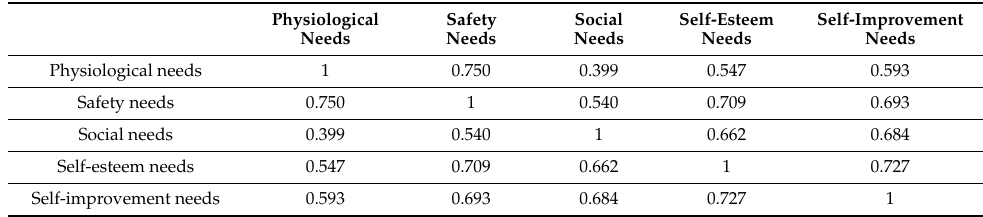
Table 3. Pearson Correlation Matrix.